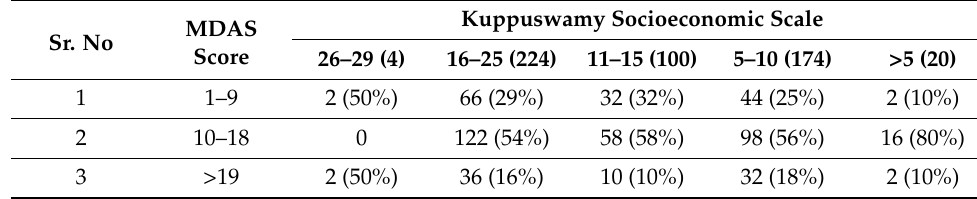
Table 4. Dental Anxiety scores according to Kuppuswamy